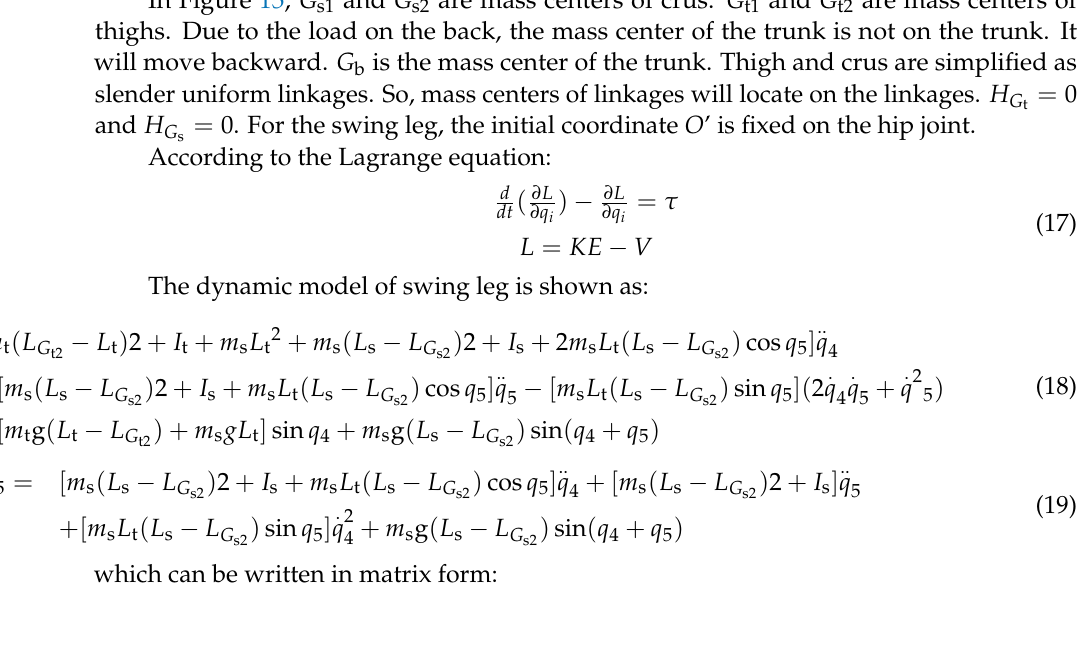
G and G are mass centers t1 t2